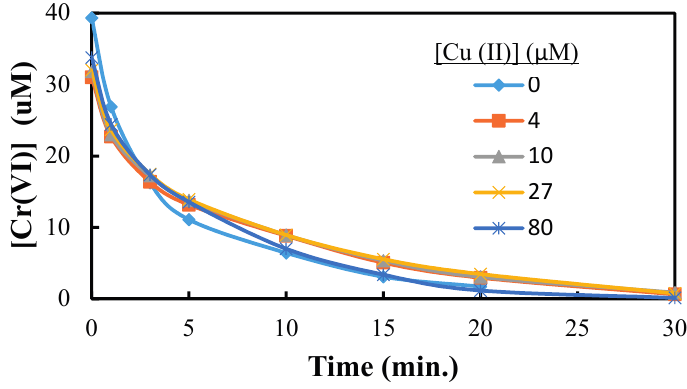
Figure 5. The reduction of Cr(VI) in the presence of Cu(II). [Cr(VI)] = 40 µM, [Cu (II)] =